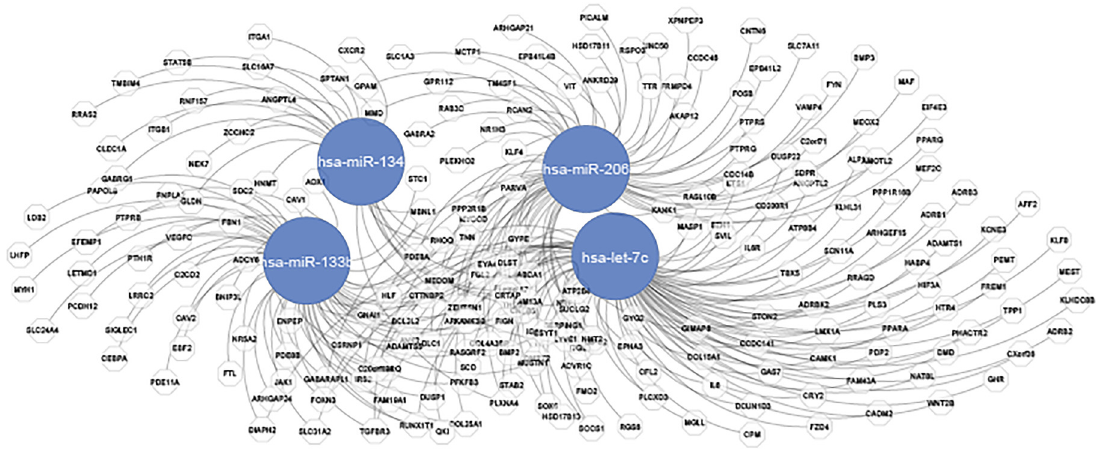
Figure 6: Interaction network between hub miRNAs and genes of turquoise